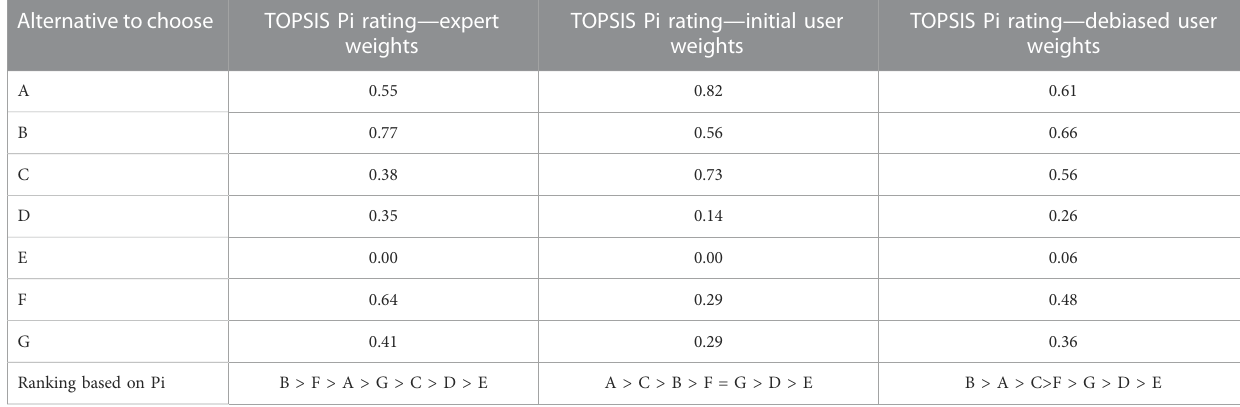
TABLE 7 Final AHP score matrix using expert weights, user weights, and debiased user weights. Pi stands for performance score. Alternative to